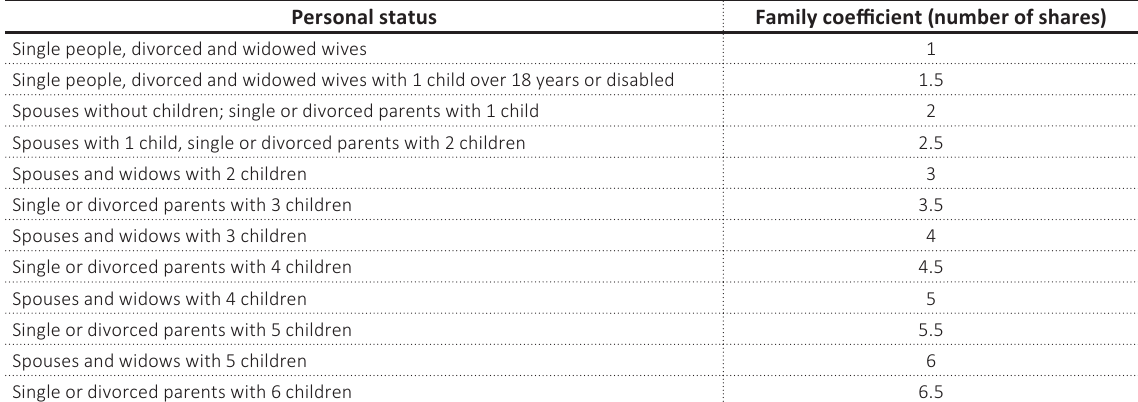
Table 4. Family coefficients in